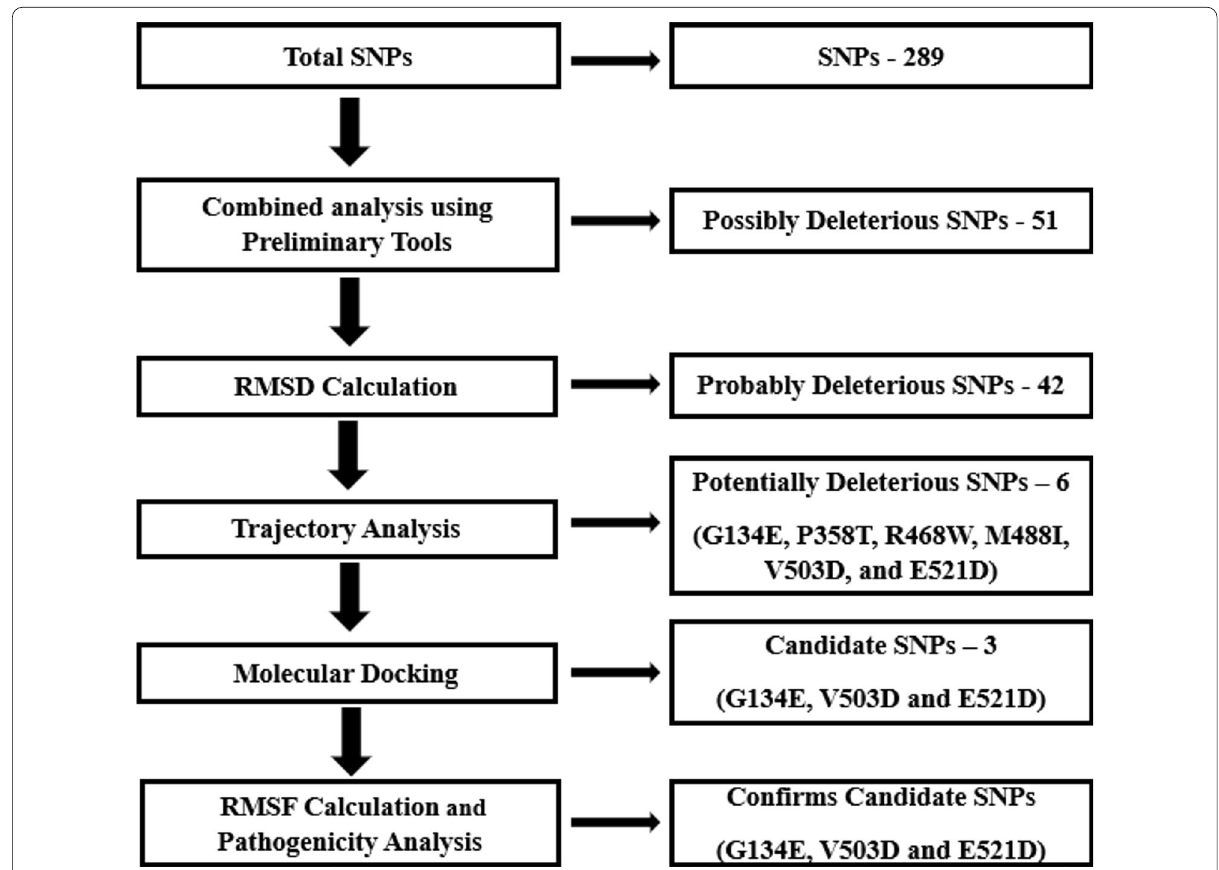
Fig. 2 Result summary of the entire